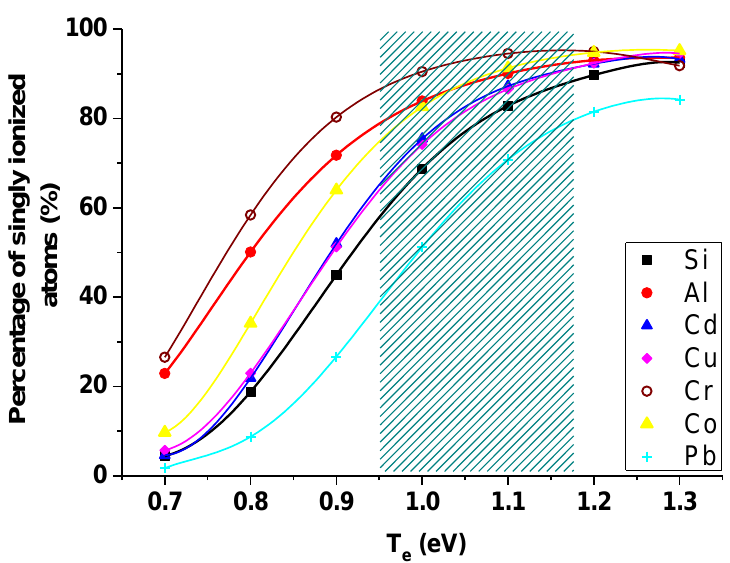
Figure 5. Number of singly ionized atoms in the temperature range of 0.7–1.3 eV and for the average electron density of 3.8 × 10 23 m − 3 (patterned part corresponds with the obtained range of T e ).